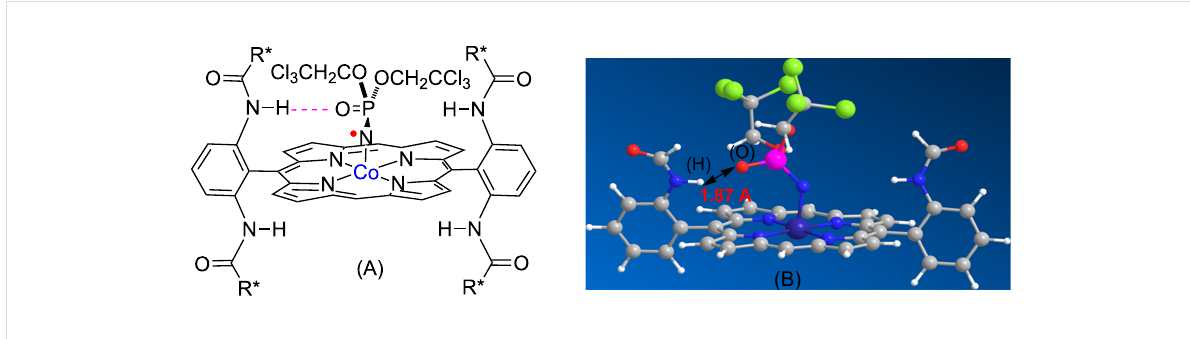
Figure 1: (A) Potential H-bonding interaction in postulated nitrene radical complex of [Co( D 2 -Por*)]. R* represents a chiral unit. (B) Geometry corres- ponding to the minimum energy from simplified computer modeling by molecular mechanics with Spartan 10. The P=O … H–N distance of (1.87 Å) suggests possible existence of significant hydrogen bonding interaction. However, besides computer modeling there is no direct experimental evi- dence for such interactions. For clarity, the other two meso -groups of the porphyrin are omitted in both (A) and (B). In addition, the other two amido units below the porphyrin ring are also omitted in (B).